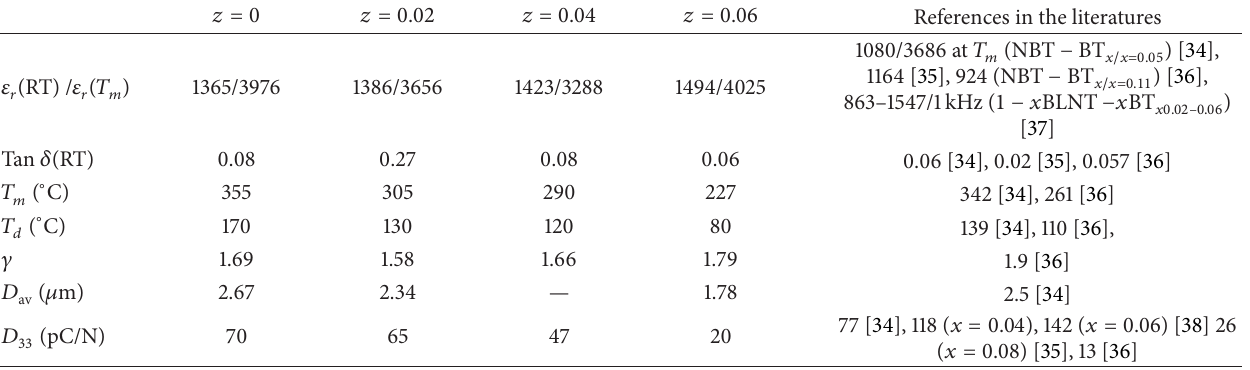
Table 2: Dielectric and piezoelectric properties of [ 1 − 𝑧 BLNLT- 𝑧 BT] compared with the literature values. 𝑧 = 0 𝑧 = 0.02 𝑧 = 0.04 𝑧 =